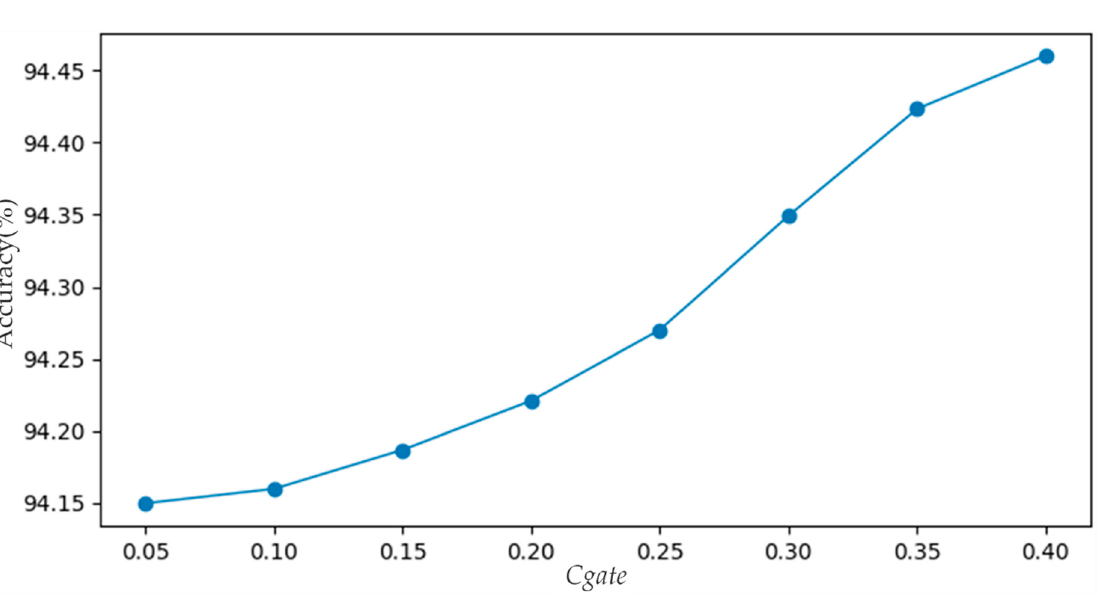
Figure 10. The relationship between the average segmentation accuracy and Cgate .